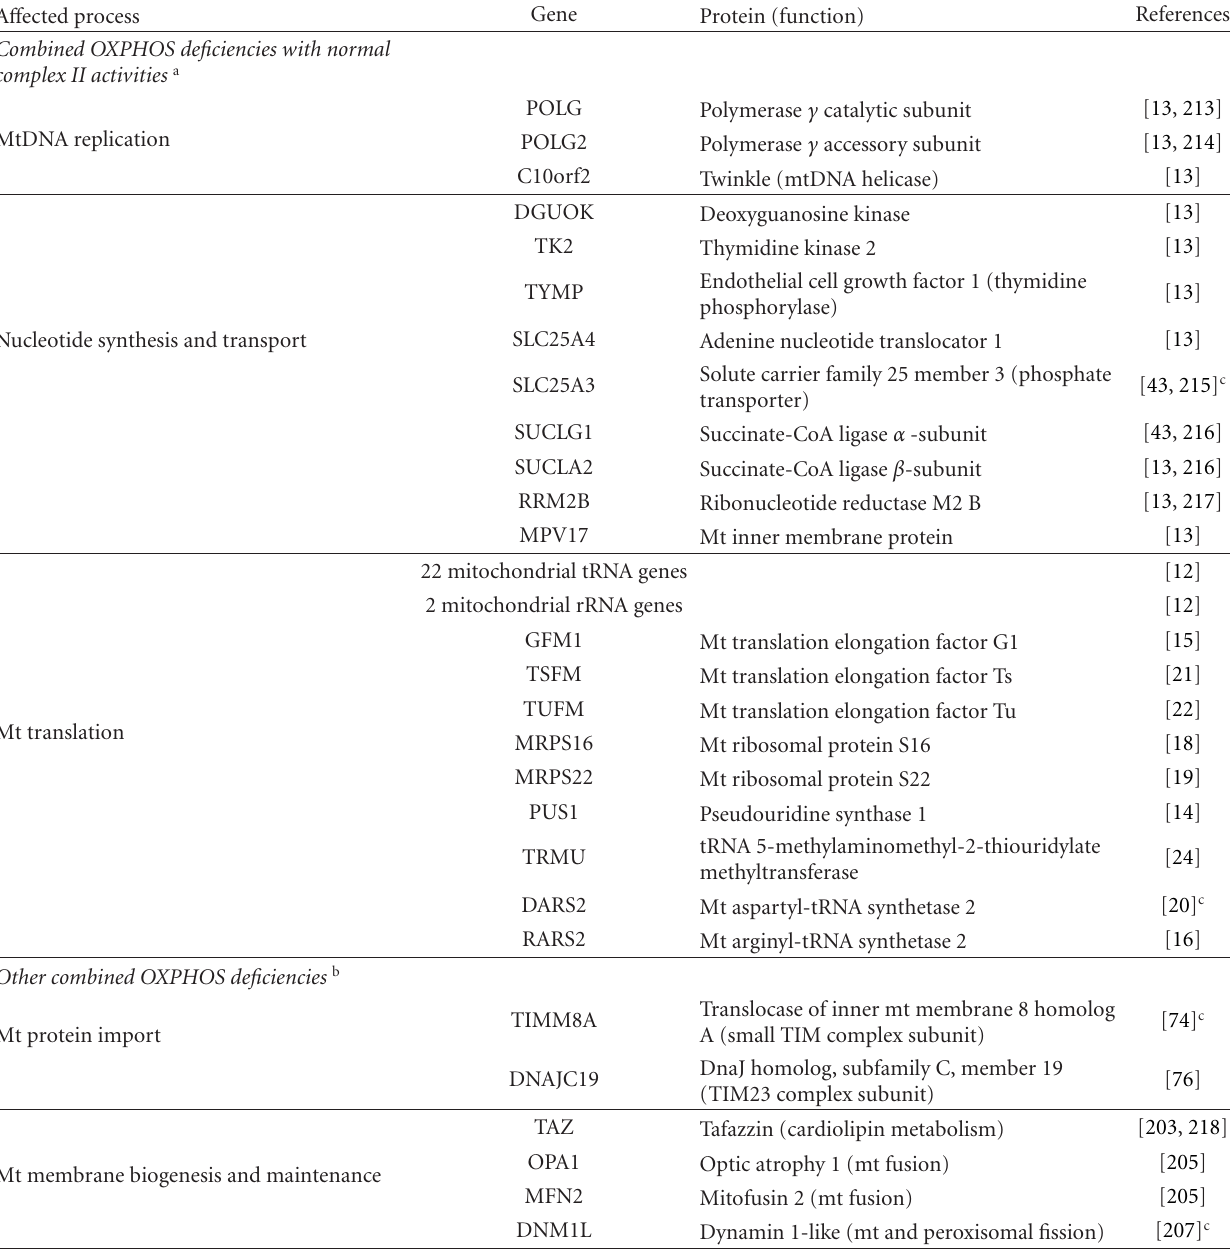
Table 1: Genes involved in the biogenesis or maintenance of multiple OXPHOS complexes and implicated in mitochondrial